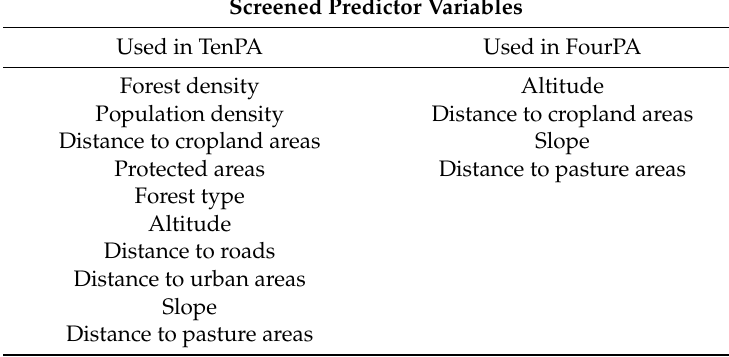
Table 2. Ten predictors used in PREDIT model. The model was run on two alternatives: (i) TenPA, which uses 10 predictors; (ii) FourPA, which uses four predictors substantially associated with the dependent